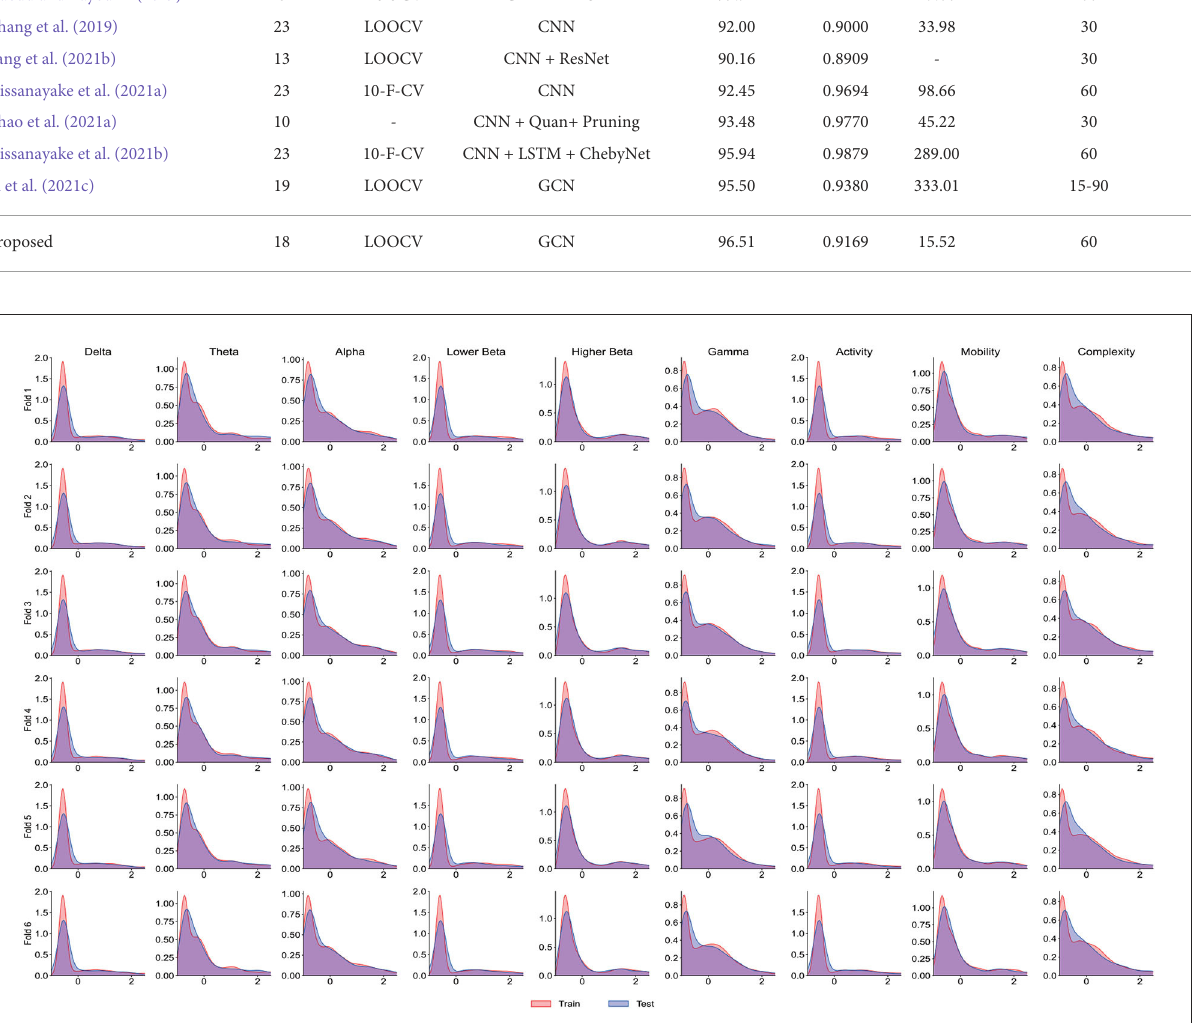
FIGURE5 The distribution curve of the training set and test set of